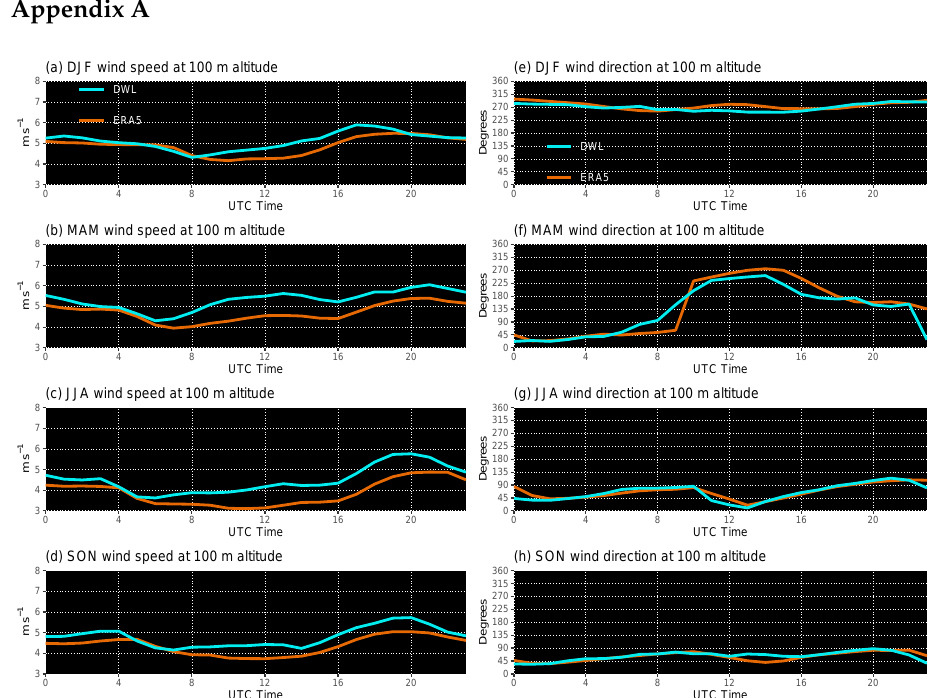
Figure A1. Seasonal diurnal wind speed ( left ) and wind direction ( right ) at 100 m retrieved from DWL and ERA5 reanalysis.